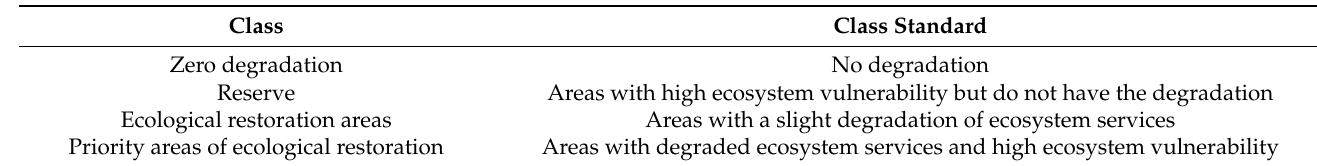
Table 2. Ecological restoration zoning standards.